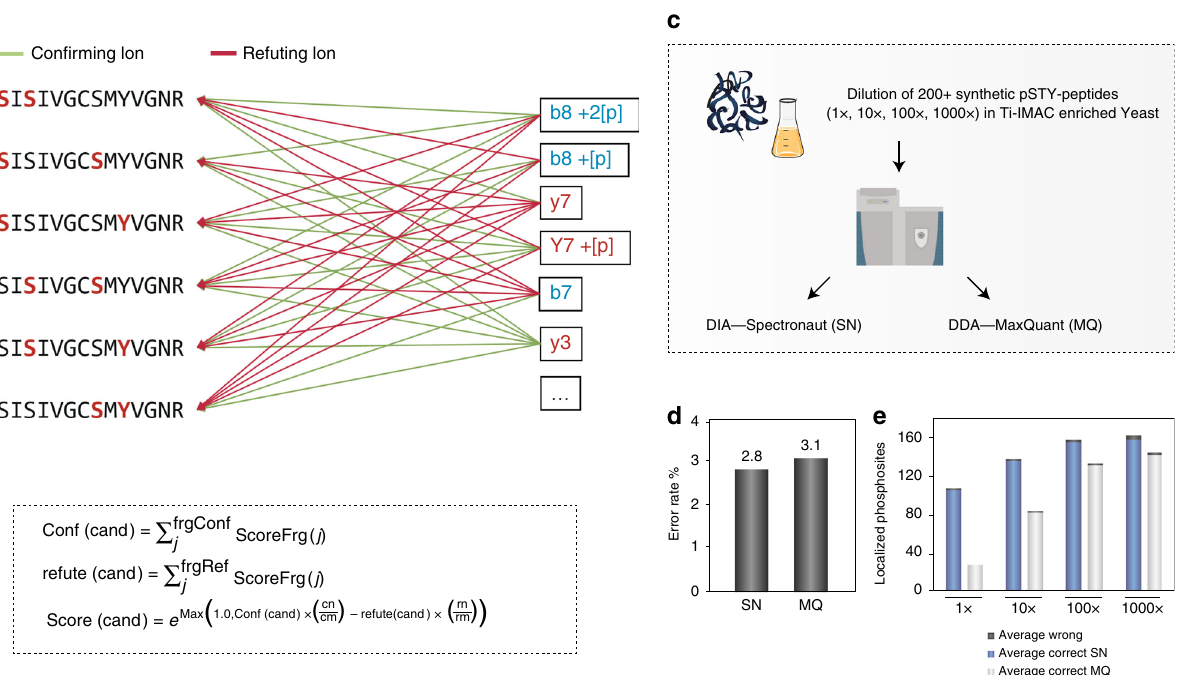
Fig. 2 Challenges and solutions for phosphoDIA. a Con fi rming and refuting fragments for site localization. b Calculation of site localization con fi dence score. The score for a given site localization candidate is calculated by summing all con fi rming fragments matched and subtracting the sum of all refuting fragments matched. c Work fl ow to evaluate localization algorithm with MaxQuant. d Error rates for phosphorylation site assignment in DDA and DIA. e Coverage of assigned phosphorylation site in a diluted yeast background for DDA and DIA. Source data for this fi gure are provided as a Source Data fi